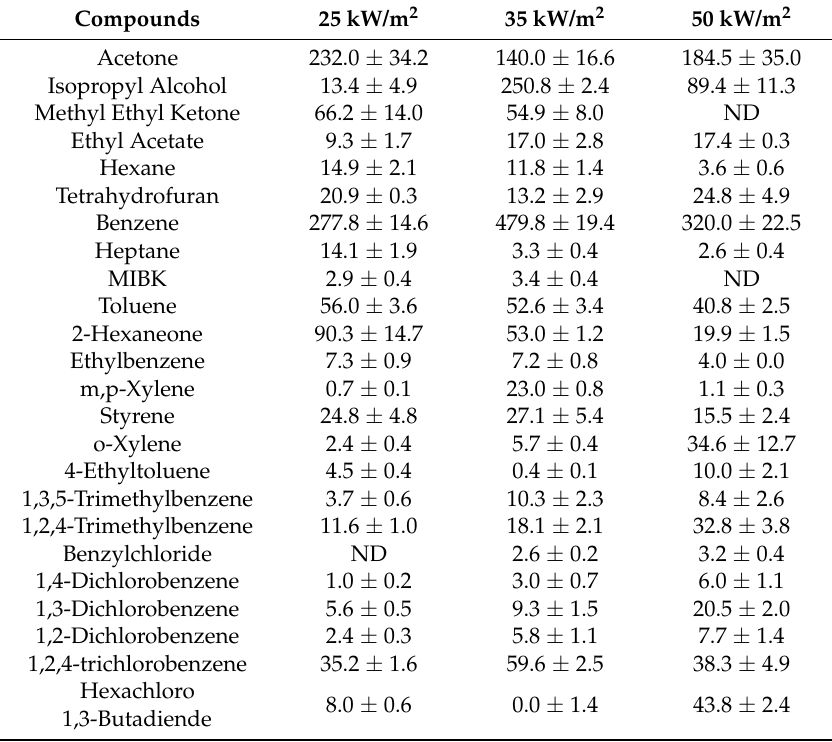
Table 4. Emission factors (mg/kg) of VOCs from the combustion of